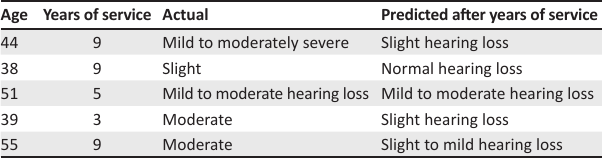
Source : Table created using data from Moroe, N.F. (2018). Occupational noise-induced hearing loss in South African large scale mines: From policy formulation to implementation and monitoring . Doctoral thesis. Johannesburg: University of the Witwatersrand.